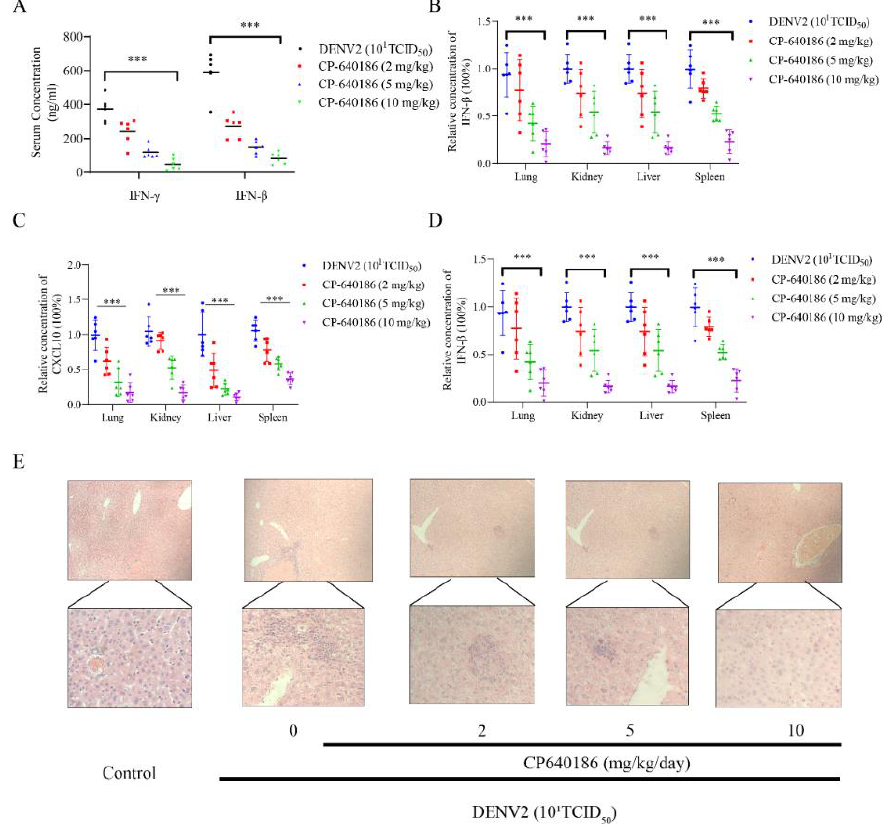
Figure 6. The influence on inflammatory factors of CP640186 in vivo. ( A ) The concentrations of IFN- β and IFN- β were detected by ELISA of the mouse serum in Figure 5A. The mRNA levels of ( B ) IFN- β , ( C ) CXCL10, and ( D ) IL-1 β were analyzed by RT-qPCR in Figure 5A. ( E ) The hematoxylin–eosin staining (HE) results of liver tissue: the top figures are 10 × magnified, the bottom figures are 40 × . *** indicates p <